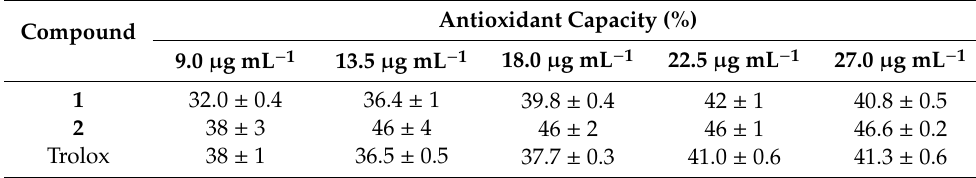
Figure 3. Percentage of ABTS • + remaining. Table 2. Antioxidant capacity of compounds 1 , 2 and Tx against OH • radical.